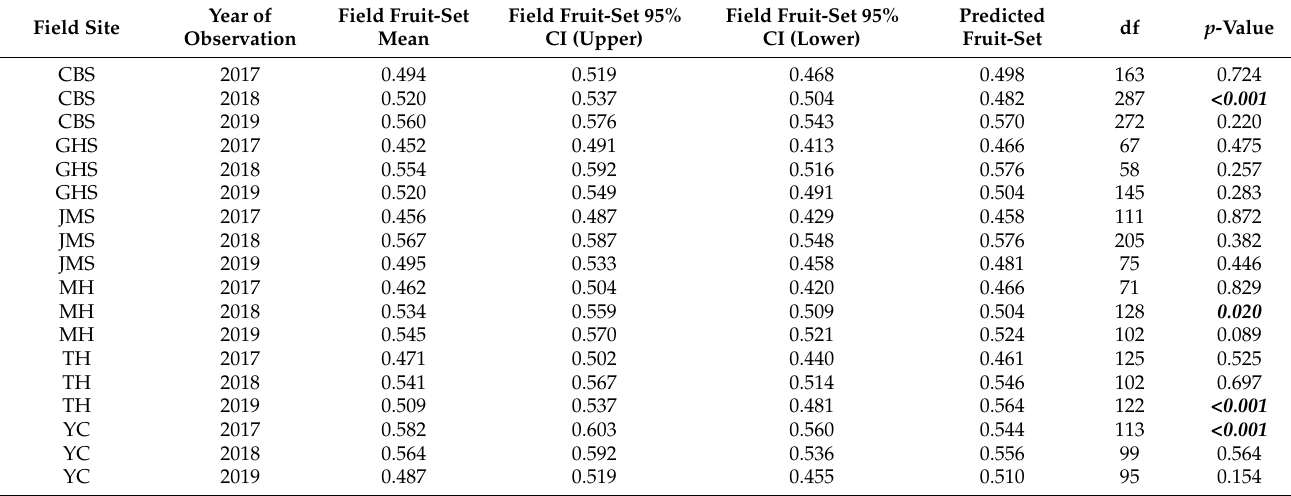
Figure 7. Accuracy of bog blueberry fruit-set prediction before ( A , C , E , G , I ) and after ( B , D , F , H , J ) parameter optimizations were conducted. The prediction accuracy is defined as the coefficient of determination (R 2 ) of the linear regression between predictions and observations in fruit-set. Table 4. Validation results of the calibrated metamodel (XGBoost). The model predictions were compared with field observations in six sites (CBS, GHS, JMS, MH, TH, and YC) in the years between 2017–2019, using the Wilcoxon Signed-Rank test. Bold and italic numbers indicate statistically significant differences ( α = 0.05), which means that the metamodel failed to predict bog blueberry fruit-set in a specific field site and